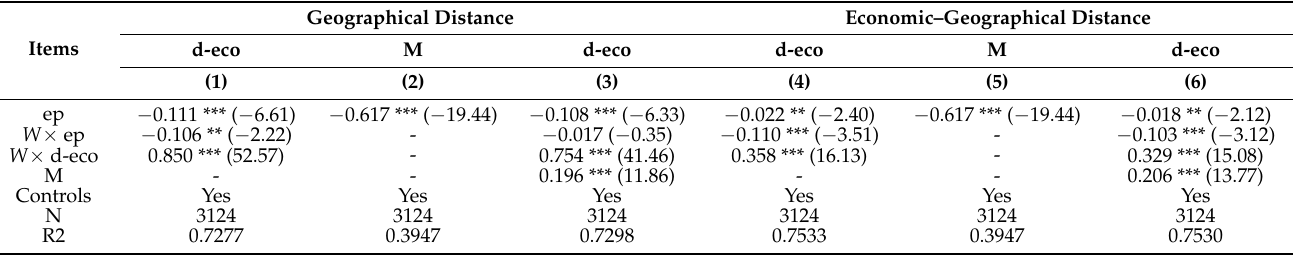
Table 9. Mechanism test of talent crowding out effect.